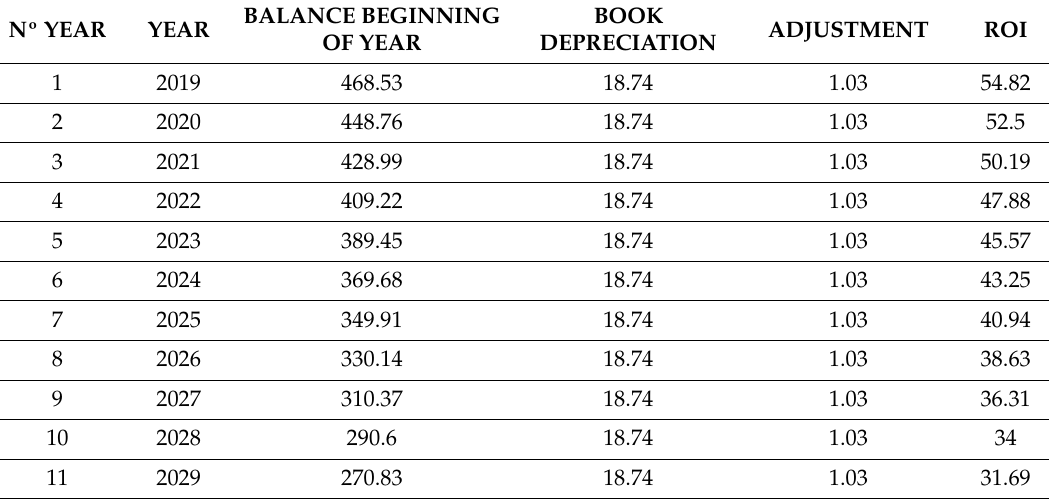
Table A6. Return of interests (ROI) on preferred stock (10%) (in millions of